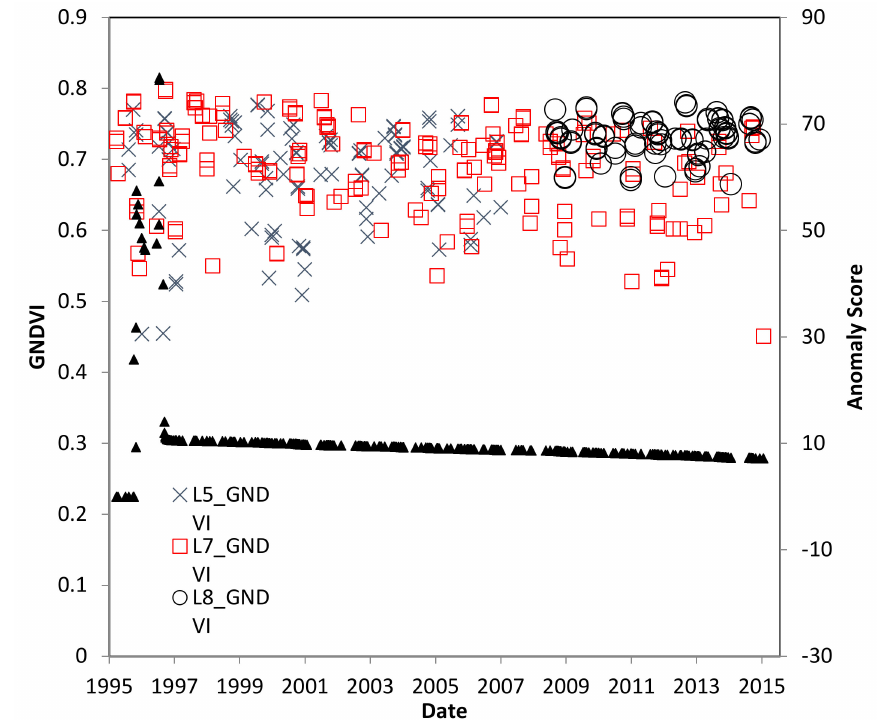
Figure 12. GNDVI over time for the Par á , Brazil study location. R. indica was not observed at this